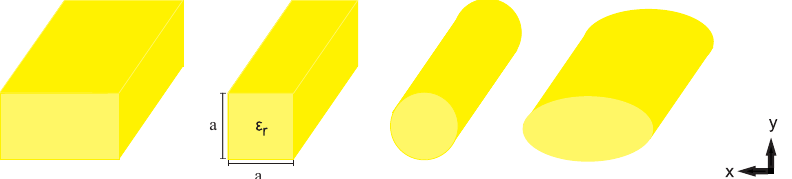
Figure 1. Cross-section geometries of a dielectric waveguide from left to right: rectangular, square, round, and